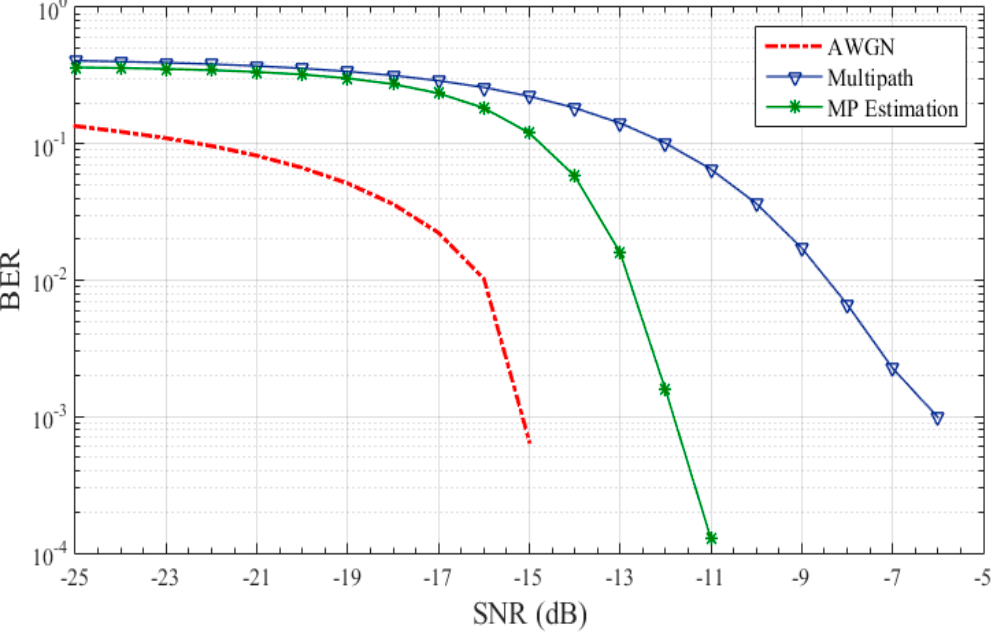
Figure 16. BER curve of mimicked signals at a five km distance.